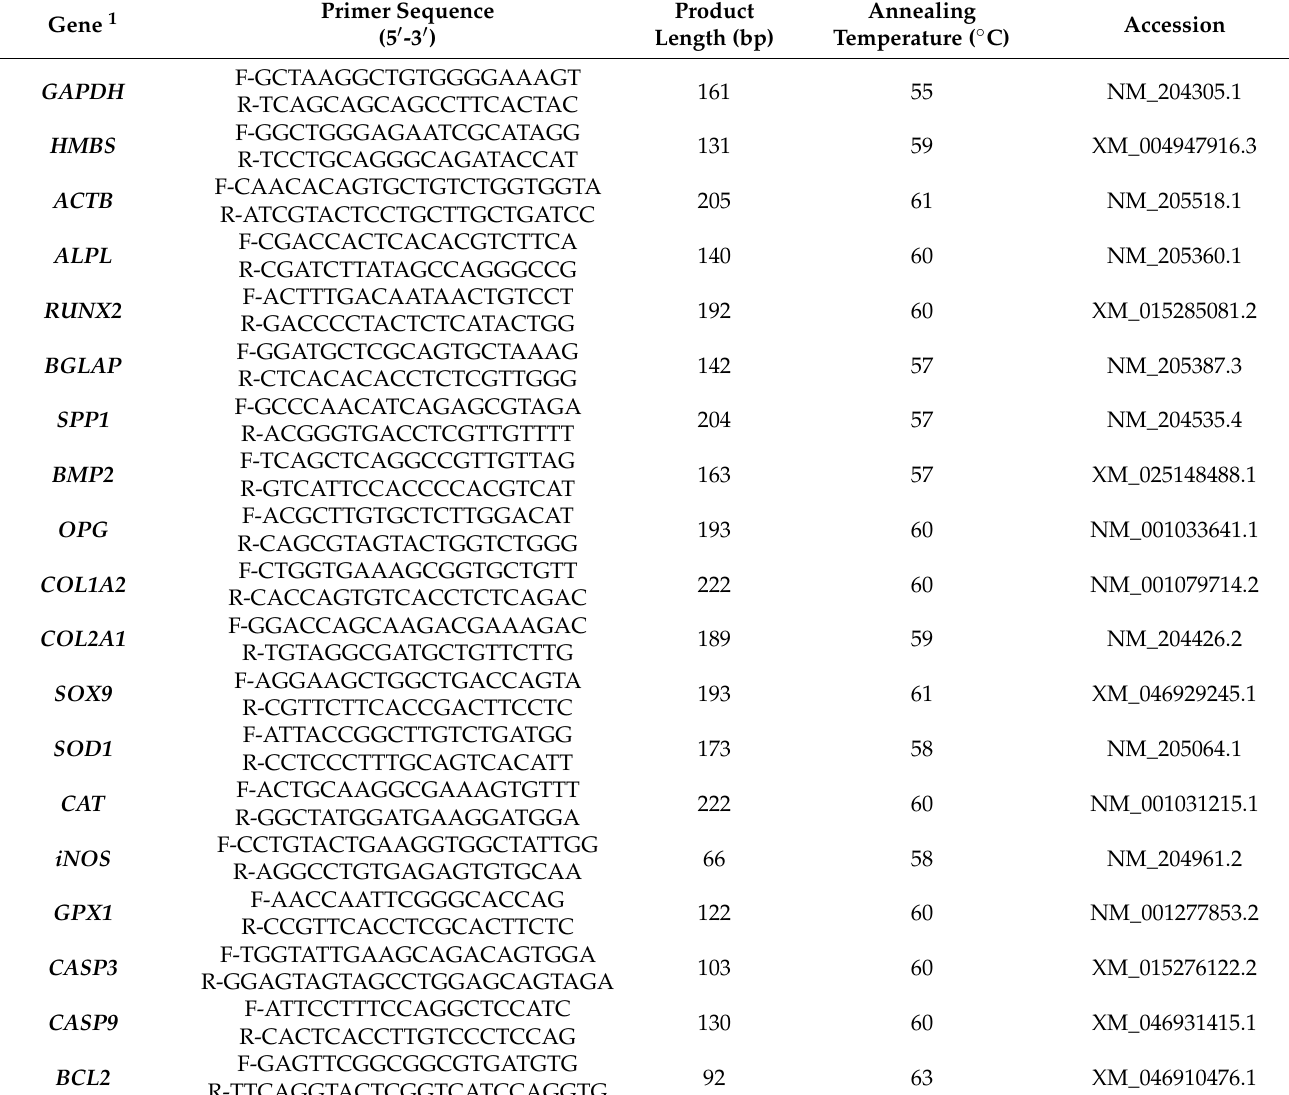
Table 1. Nucleotide sequences of the primers used for quantitative real-time